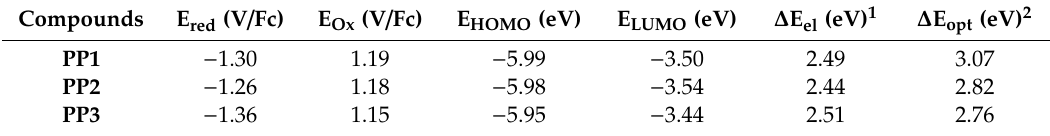
Figure 11. Selected examples of cyclic voltammograms of studied compounds ( PP9 , PP19 ) and Ferrocene (Fc). Table 6. Electrochemical redox potentials of the studied compounds PP1–PP20